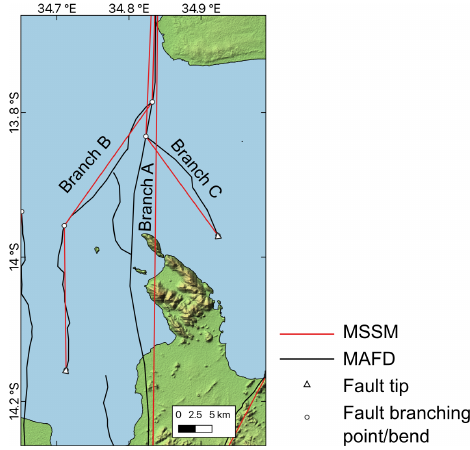
Figure A1. Example of Malawi Seismogenic Source Model (MSSM) branches at the southern end of the South Basin fault 13. In the interpretation that the fault does not splay (branch A), the branching points are not considered when connecting fault tips to define the source geometry and, hence, results in some overlapping projections with branches B and C. We note here that this oversim- plification in source geometry may also occur in other branching MSSM sources; however, the difference it makes in source length is negligible ( < 1km for the 100km long South Basin fault 13 shown here). MAFD is the Malawi Active Fault Database (Williams et al.,